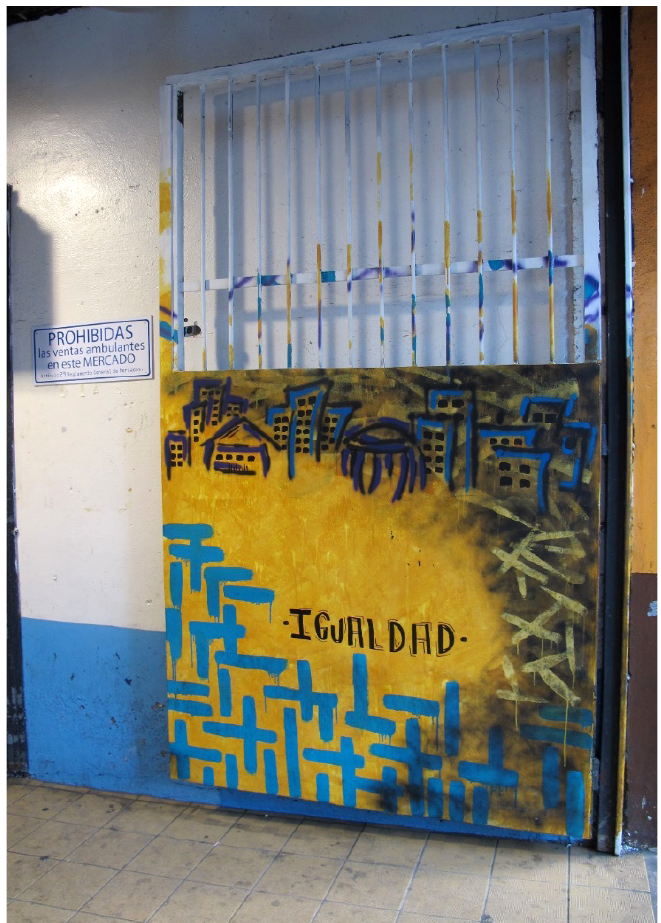
Figure 1. Popular art in the central market of San José, Costa Rica, emphasising equality, beside a sign which prohibits the access of informal traders to the market. Photo by Anja